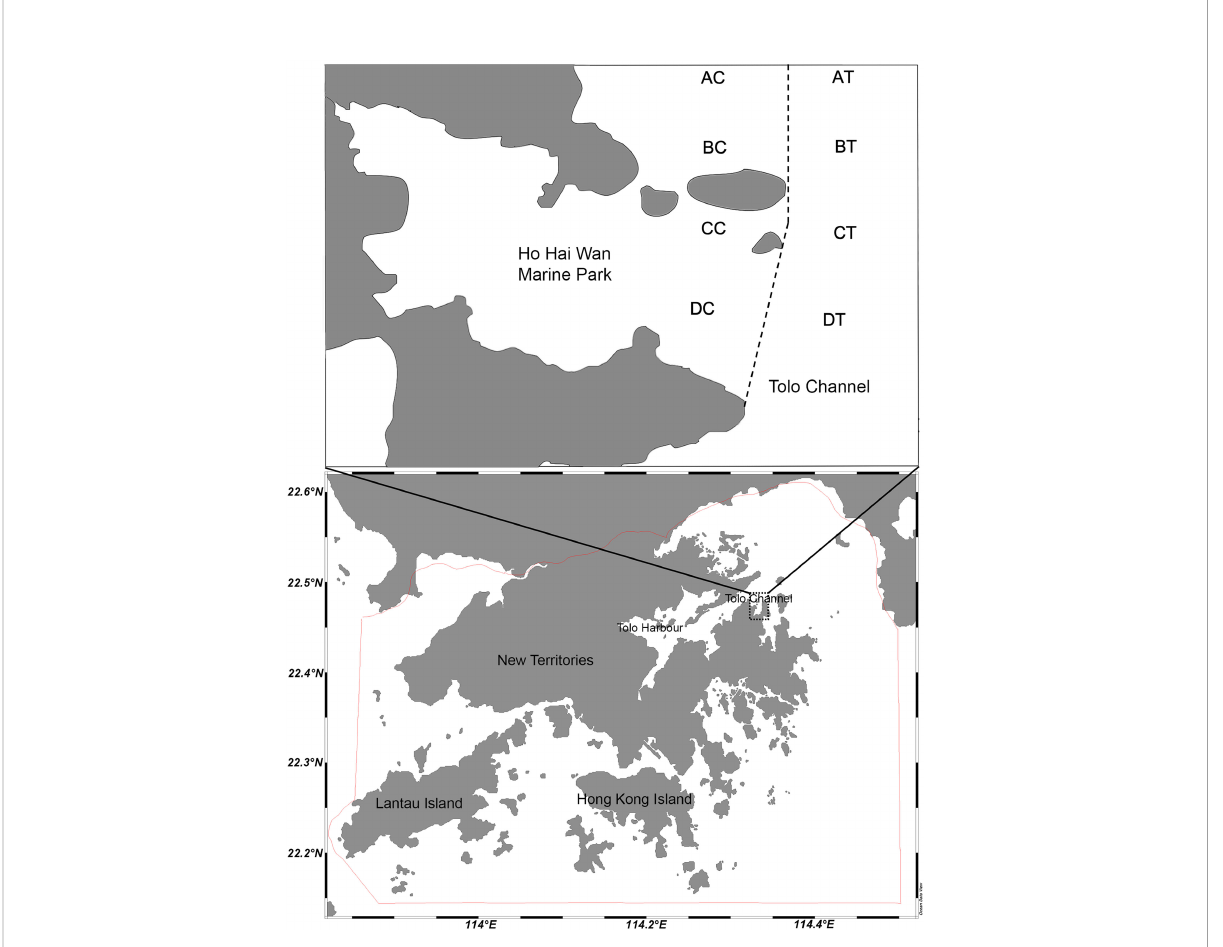
FIGURE 1 Map showing sampling sites AC-DC in the non-trawled area inside the Hoi Ha Wan Marine Park and AT-DT in the trawled area along the Tolo Channel. The dotted line indicates the boundary of the marine park and the red line shows the boundary of territorial waters of Hong